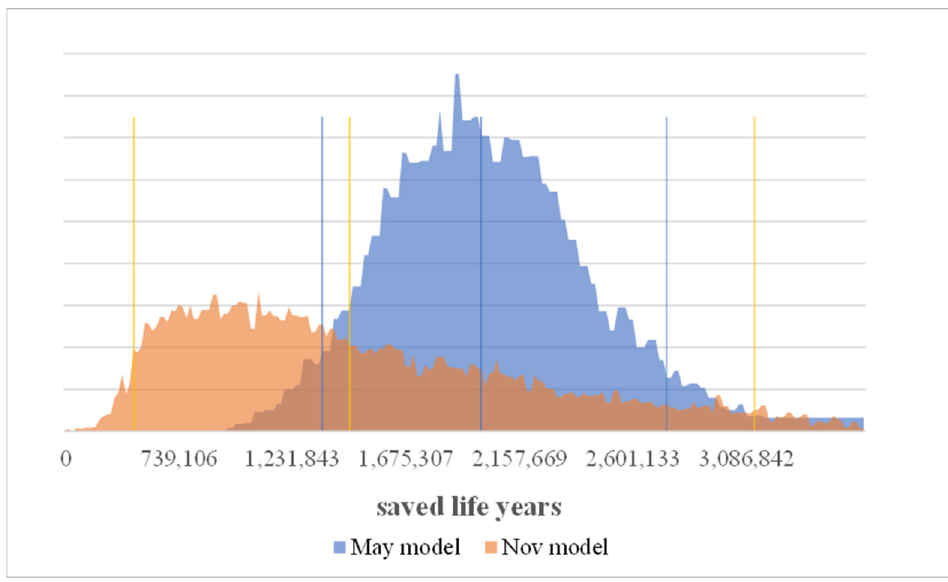
Figure 4. Number of deaths without measures at the end of the analyzed period.